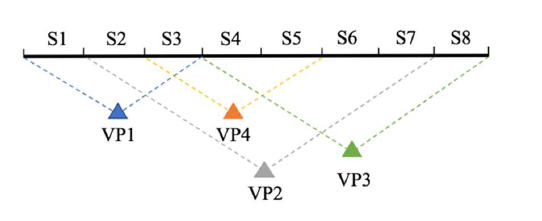
Figure 1. Example 1: S1 to S8 are wall segments to be scanned, VP1 to VP4 are VP candidates to be selected. The visible zones for VPs are represented by different colors of dashed lines.